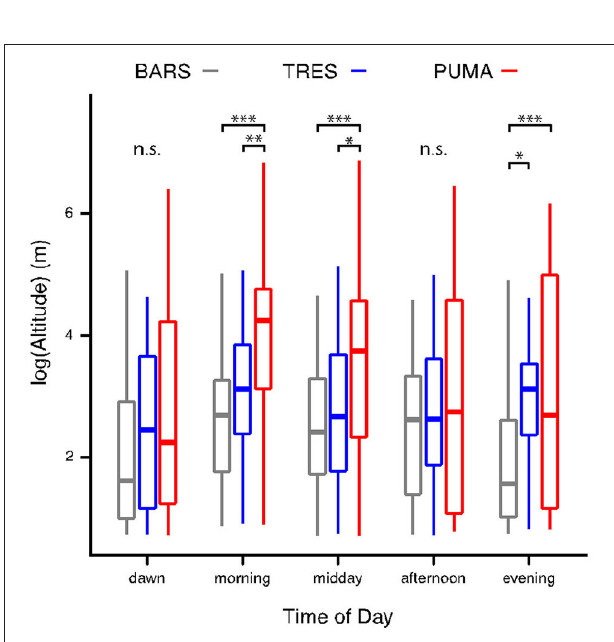
FIGURE 2 | Differences in altitude at different times of day for 3 study species—We compared the median log flight altitude of each flight bout between species using a linear model with pairwise comparison of contrasts using a Tukey HSD test. In 3 out of 5 time bins, there were significant differences between Purple Martins and Barn Swallows. The greatest differences between species occur in morning and midday in this study